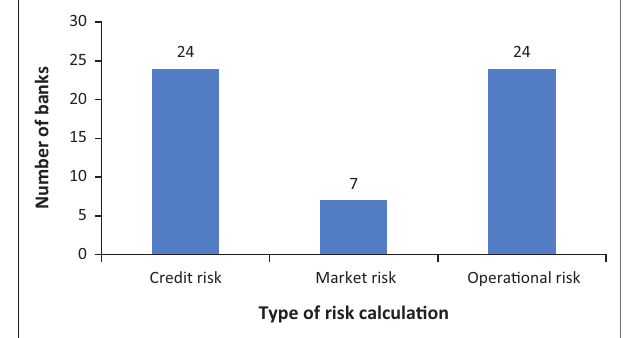
FIG URE 3: Number of banks already calculating regulatory capital for credit, market and operational risk